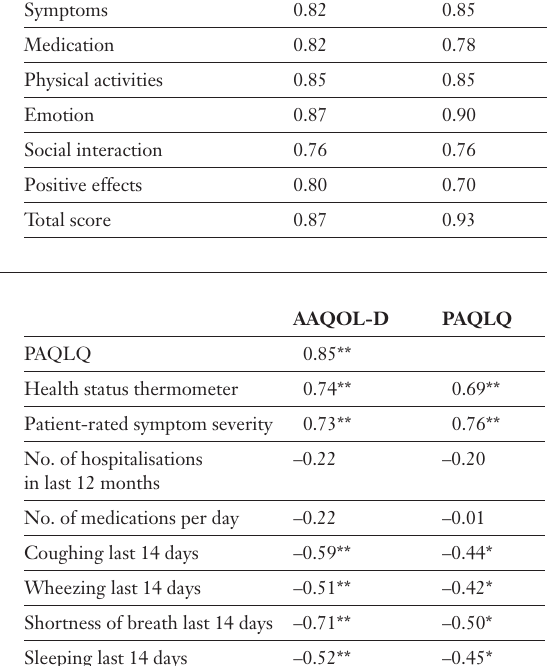
Qualitiy of life in Swiss adolescents with asthma